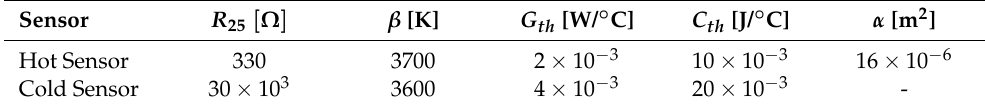
Table 7. CTD Wheatstone bridge architecture sensor parameters used in SPICE simulation.